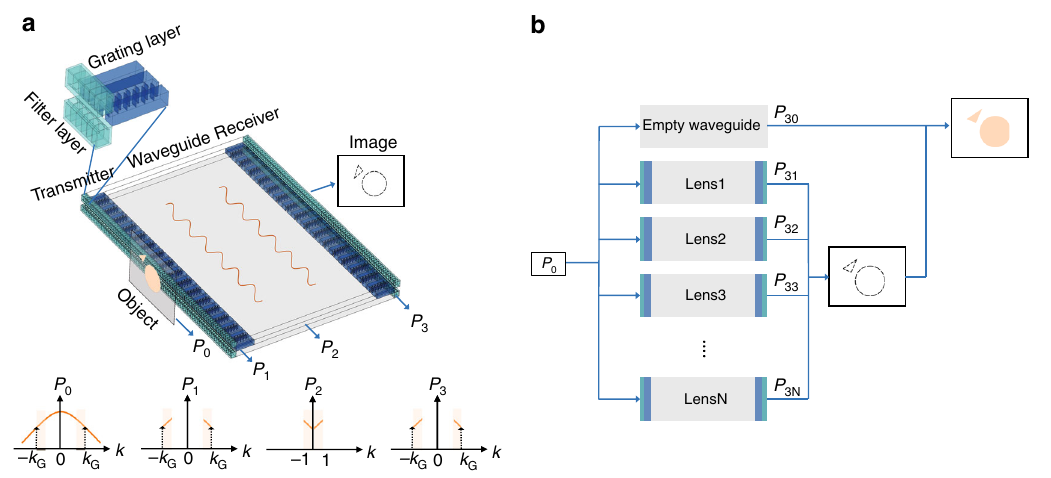
Fig. 1 System schematics and the working process of the proposed system. a System schematics. The whole system is composed of a transmitter and a R p ð k Þ e j ð kx (cid:2) 2 π f 0 t Þ d k , receiver that are spatially symmetrical. Each part is composed of a fi lter layer (green) and a grating layer (blue). Evanescent wave P 1 ¼ R k 1 1 p ð k Þ e j ð kx (cid:2) 2 π f 0 t Þ d k , and be converted to where | k | ∈ [ k G − k 0 , k G ], will be fi ltered out by the fi lter layer from the scattered wave by the object P 0 ¼ R (cid:2)1 0 p ð k ′ Þ e j ð k ′ x (cid:2) 2 π f 0 t Þ d k ′ , ( k ′ = k − k ∈ [ − k k > 0 or k ′ = k + k ∈ [0, k k < 0) by the grating layer in the transmitter. propagating wave P 2 ¼ R G 0 , 0] when G 0 ] when k ′ 2 p ð k Þ e j ð kx (cid:2) 2 π f 0 t Þ d k . b Imaging process. By tuning the geometric parameters of fi lter In the receiver, P 2 will be converted back to evanescent wave P 3 ¼ k 3 layer and grating layer, different subwavelength spatial frequency bands of the scattered wave from object ( P 0 ) can be separately projected to far- fi eld ( P 3 n , n = 1, 2, 3 … .). The propagating band can be obtained by propagating through empty waveguide. The full subwavelength image can be obtained by P N ¼ P summing up all the bands P n ¼ 0 3 I